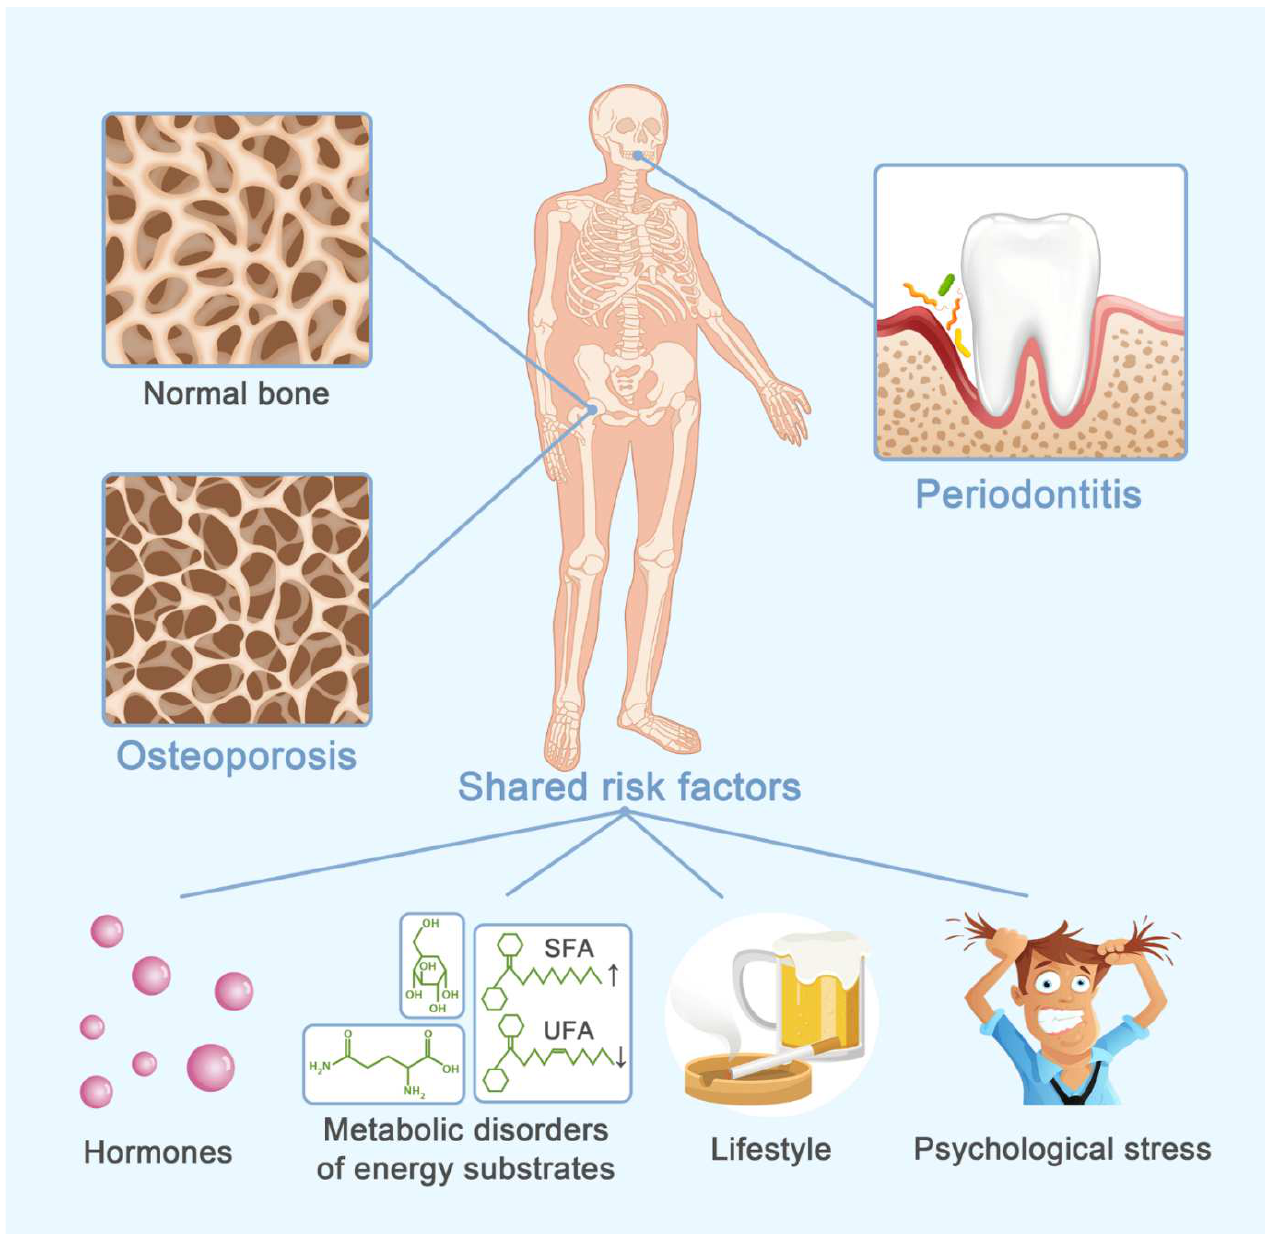
Figure 1. Shared predisposing factors for osteoporosis and periodontitis. Some predisposing factors might be the potential link between osteoporosis and periodontitis, including four categories: hormones, metabolic disorders of energy substrates, lifestyle and psychological stress.